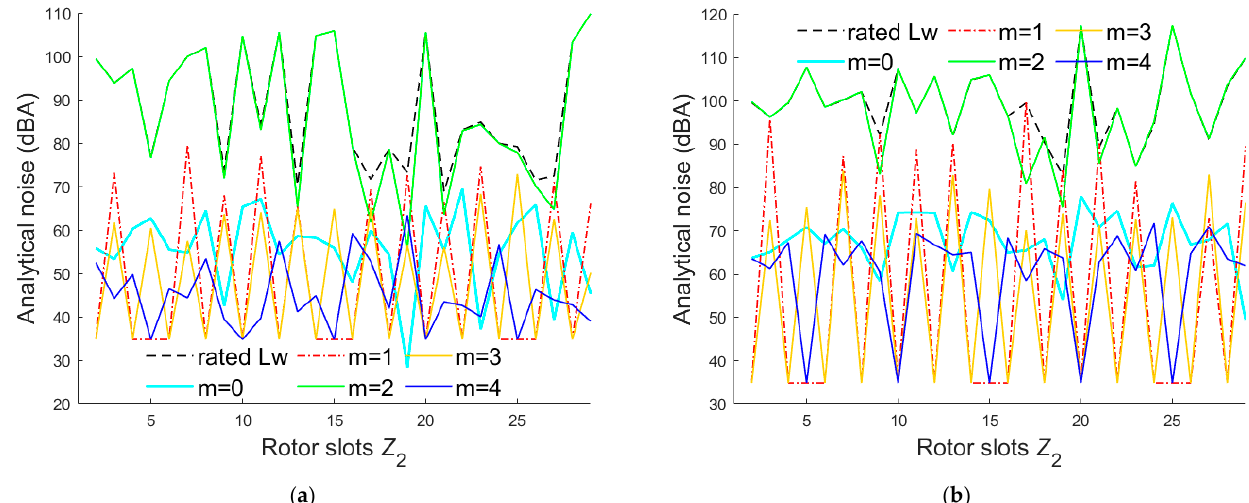
Figure 10. A Z 1 = 30 FSCIM electromagnetic sound power level in function Z 2 for both operation conditions. ( a ) Rated condition; ( b ) start-up condition.